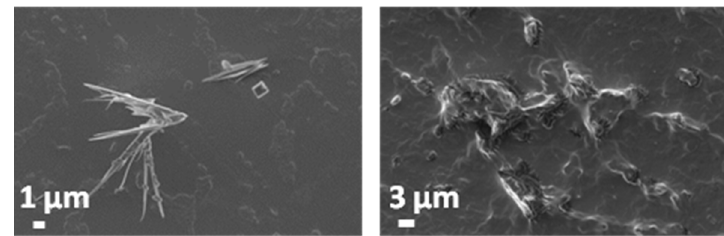
Figure 18. FESEM images of ZnO@PP sample after 21 days in artificial urine.